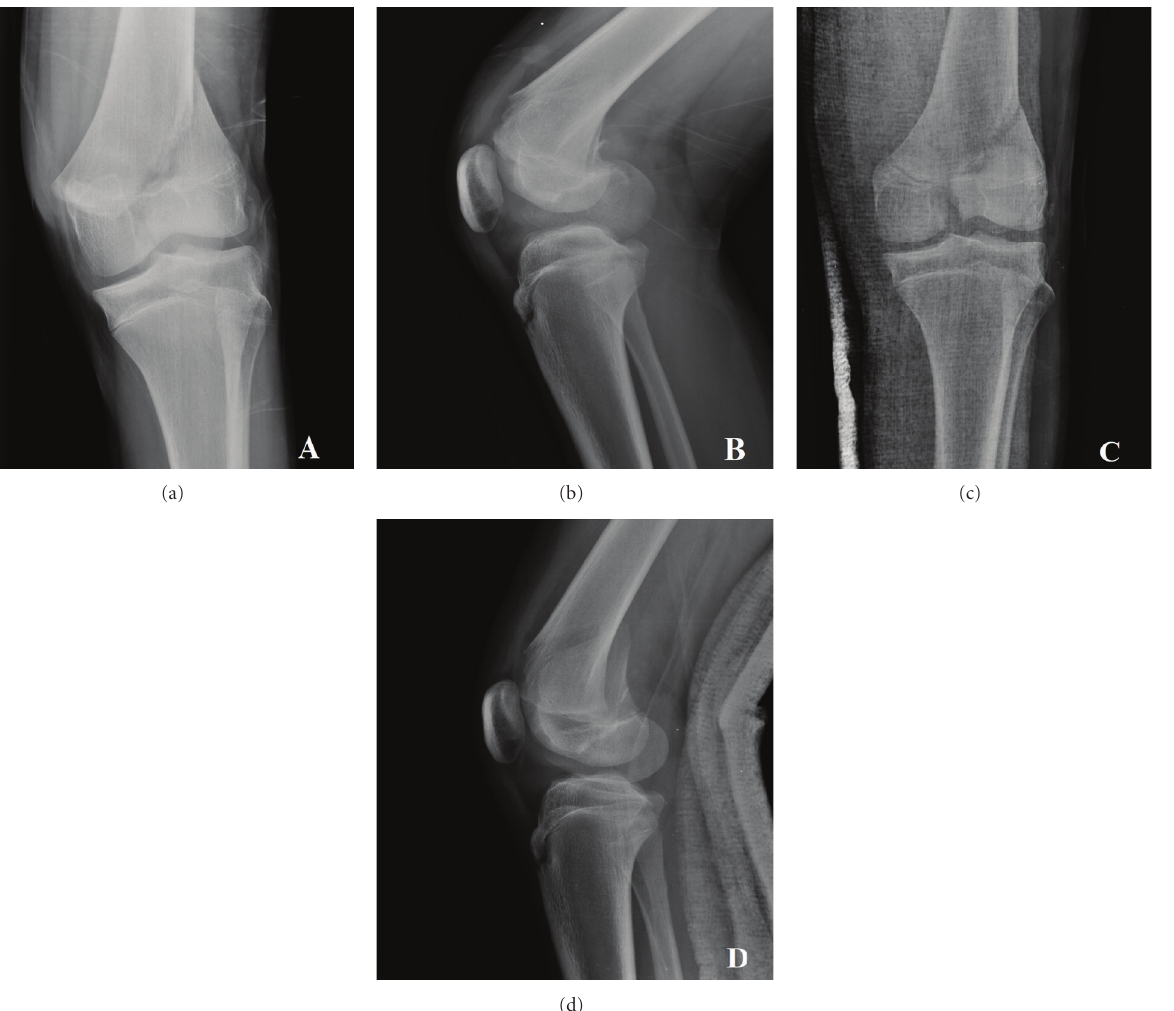
Figure 1: Anteroposterior and lateral radiograph of the left knee: Salter-Harris type III fracture of the medial physis and epiphysis, Salter- Harris type IV fracture of the lateral physis and epiphysis (a-b). Anteroposterior and lateral radiograph of the left knee after closed reduction. Salter-Harris type III fracture of the medial physis seems reduced, whereas Salter-Harris type IV fracture seems diplaced.